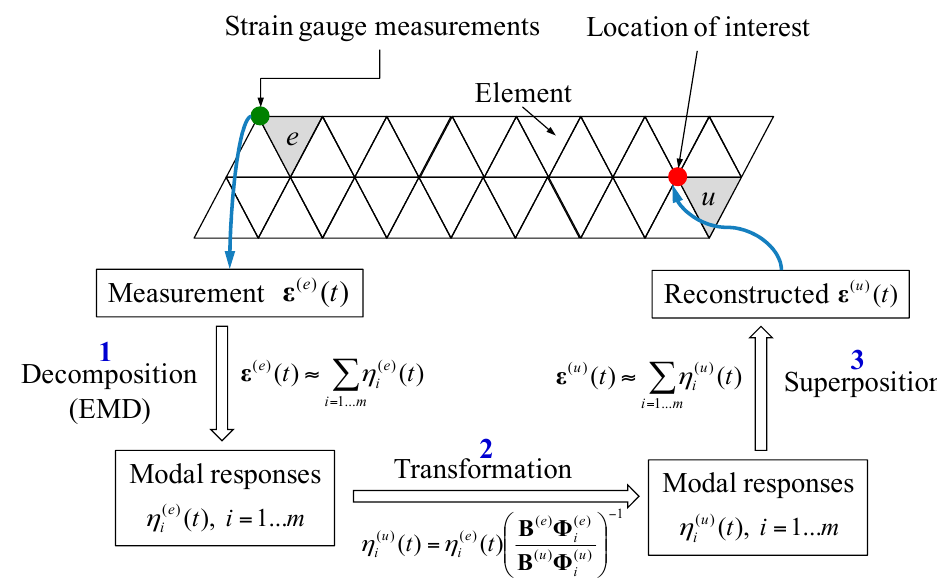
Figure 1. Flowchart of the overall strain reconstruction procedure using remote strain measurements.